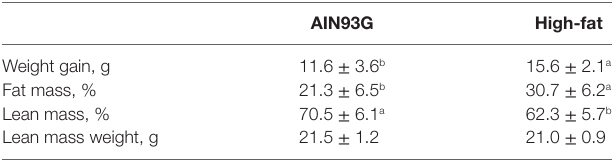
Table 2 | Weight gain and body composition of mice fed the AIN93G or the high-fat